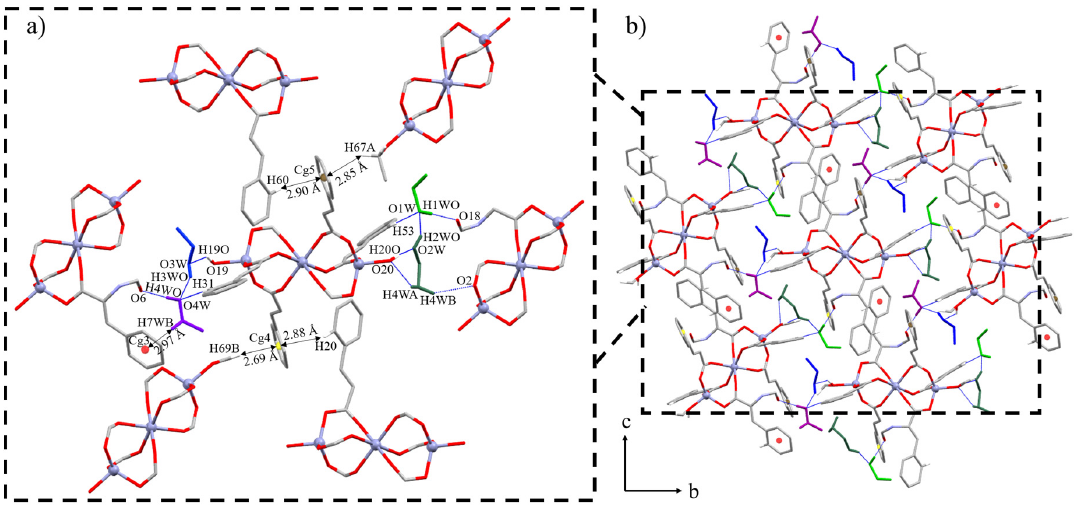
Figure 6. ( a ) In detail view of the H-bonds, C-H···O and planar interactions of complex 3 ·4EtOH. ( b ) General view of the supramolecular 2D plane formed along the bc axes. The different types of co-crystallized EtOH molecules have been highlighted in different colors and the phenyl, pyridyl, and other atoms which do not participate in any of the mentioned interactions have been omitted for clarity.